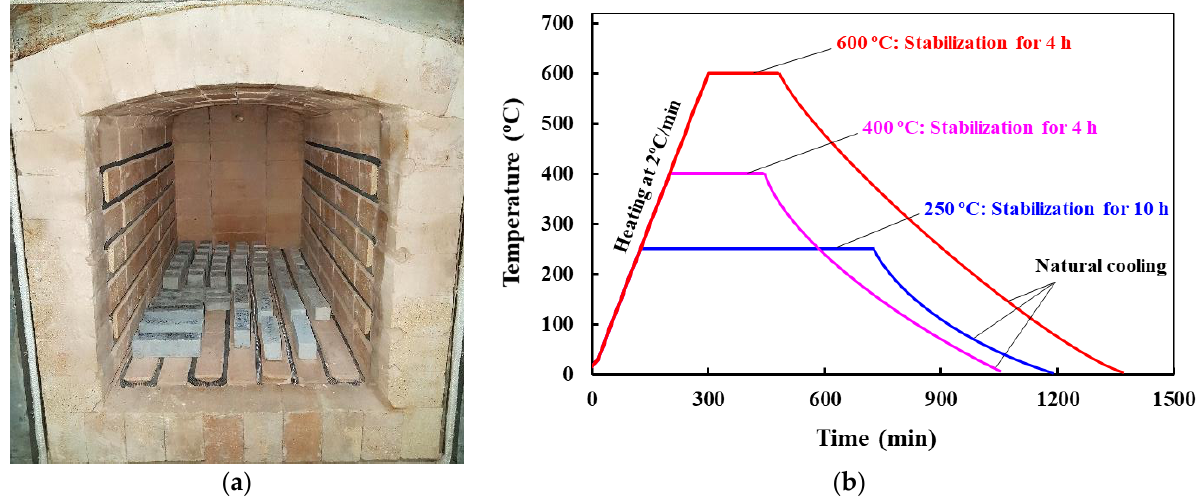
Figure 3. Electric furnace ( a ) and heating profiles of the test specimens ( b ).